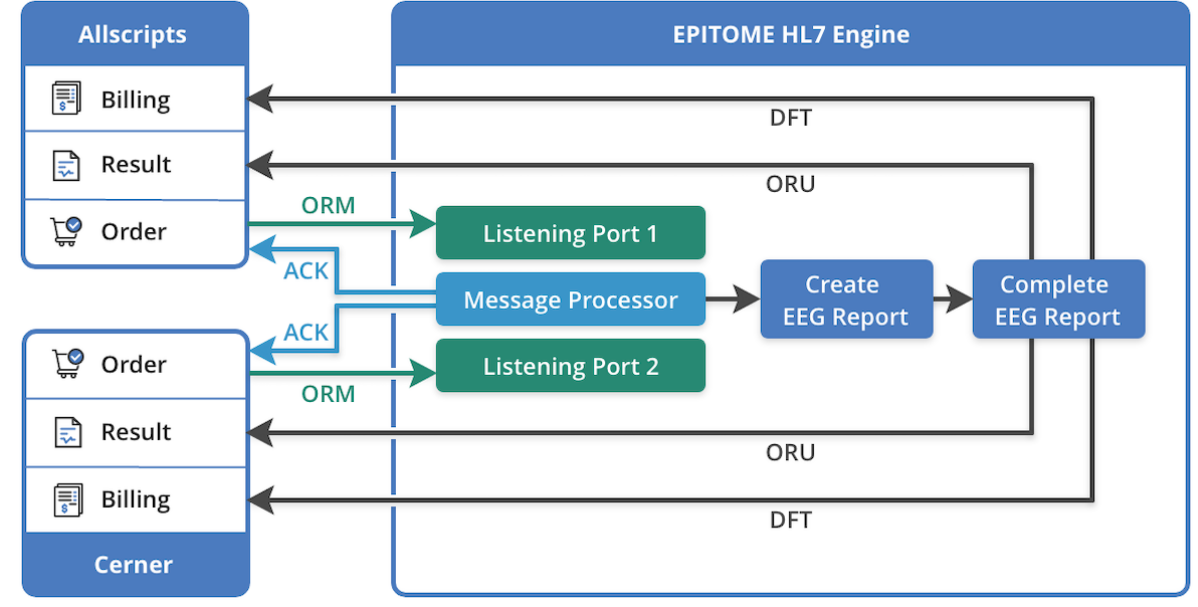
Figure 3. HL7 messaging interface between EpiToMe and the parent electronic health record systems. ACK: Acknowledgement; DFT: Detail